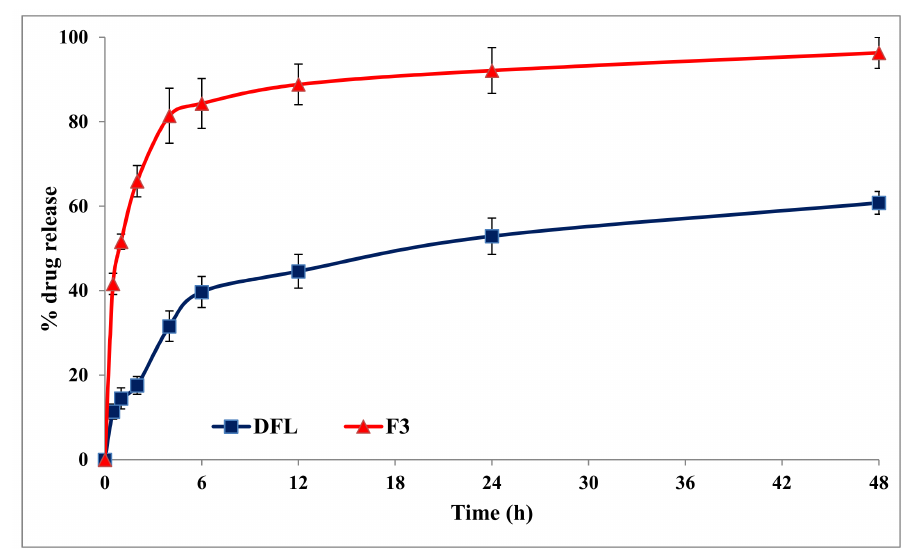
Figure 3. A comparative release profile of pure DFL and DFL-loaded L-P-NPs (F3).